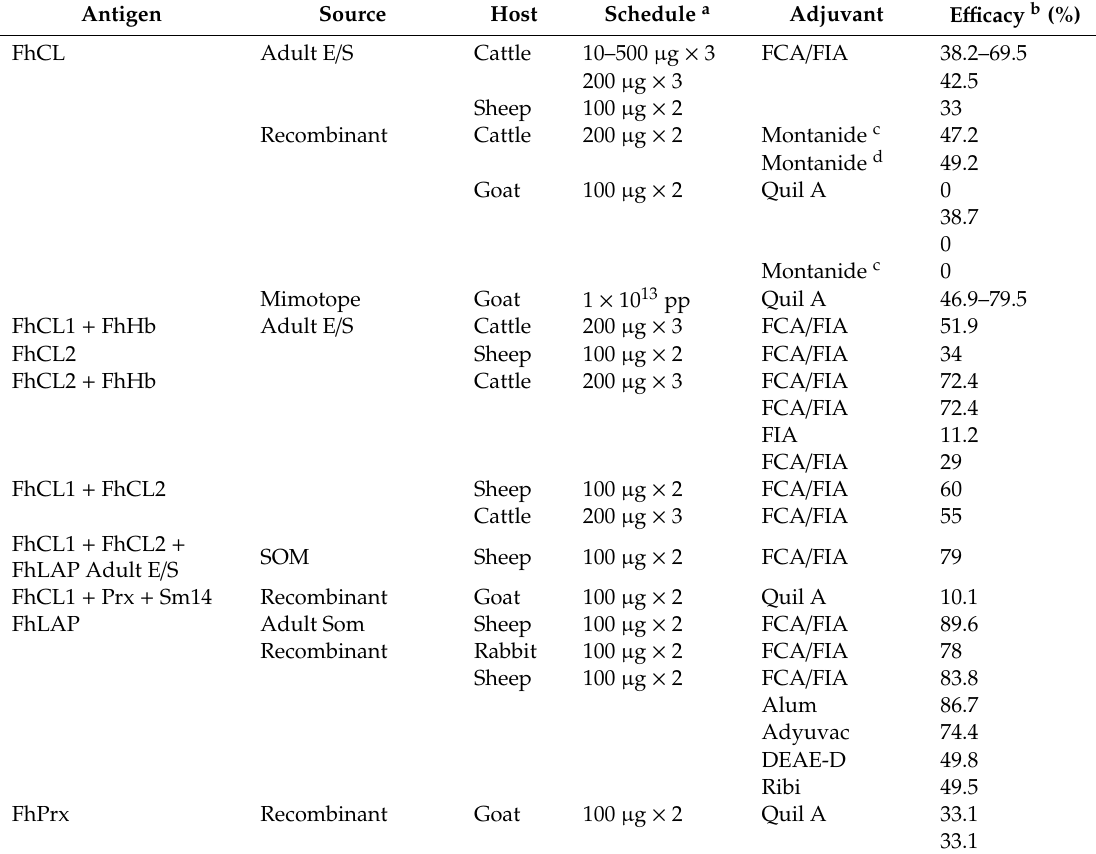
Table 1. E ffi cacy of some single or combination vaccines tested against Fasciola hepatica (Modified from [15]).